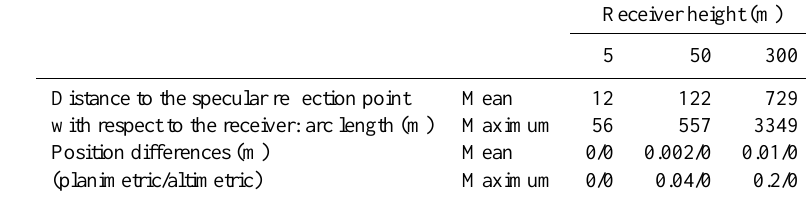
Table 1. Cross-validation between ellipsoid approximation and DEM